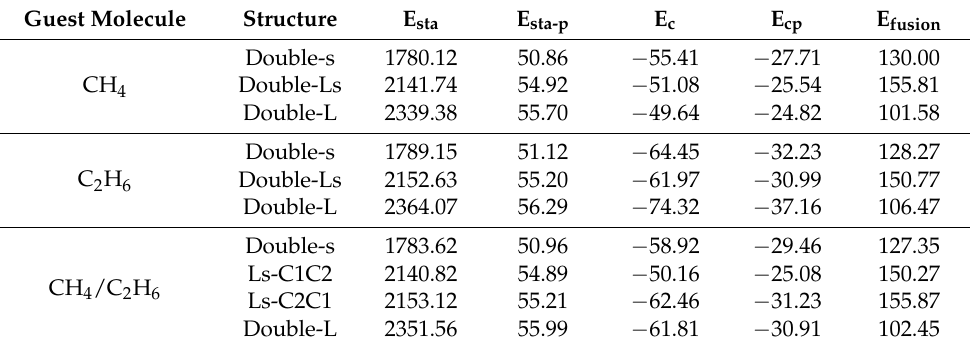
Table 2. The stabilization energy (E sta , kJ mol − 1 ), stabilization energy per H 2 O molecule (E sta-p , kJ mol − 1 ), capture energy (E c , kJ mol − 1 ), capture energy per guest molecule (E cp , kJ mol − 1 ), and fusion energy (E fusion , kJ mol − 1 ) of three guest molecules (CH 4 , C 2 H 6 , and mixed CH 4 /C 2 H 6 ) in the double-cage